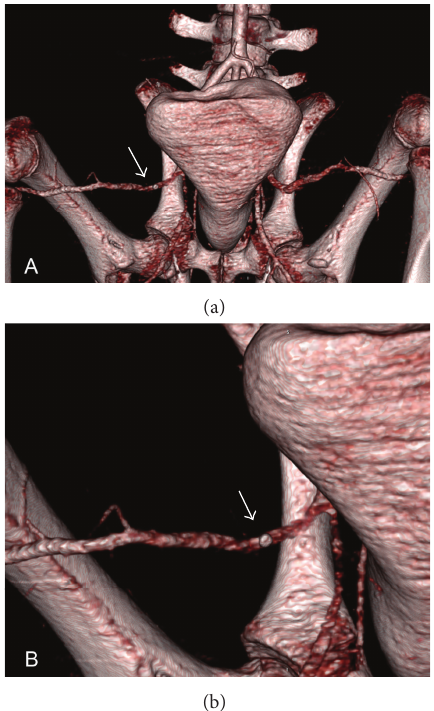
Figure2:Three-dimensionalvisualizationofaCTdatasetinarterial contrast phase using volume rendering technique (VRT). (a) VRT after application of the VCD and (b) close-up of right FA with VCD clip in situ. Note unimpeded patency of the right femoral artery after VCD application. Note markedly different anatomy when compared to human